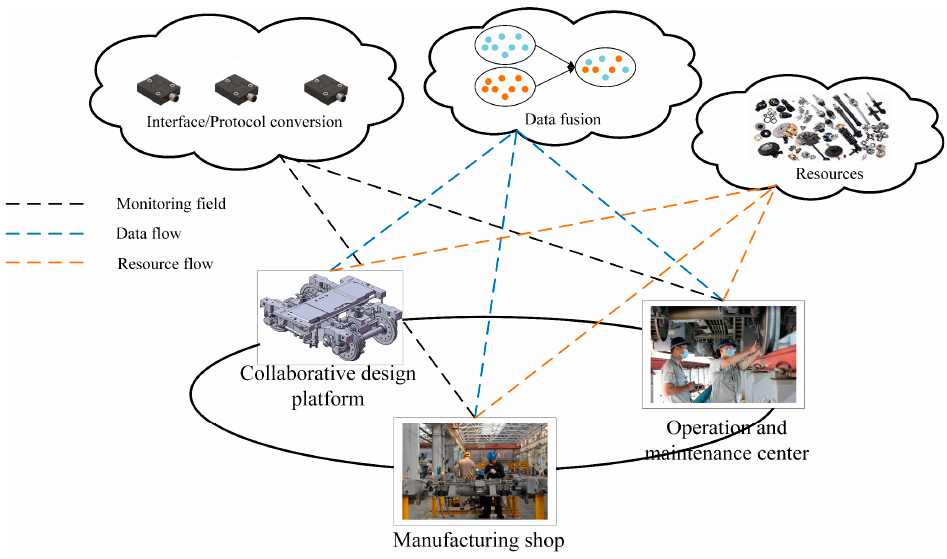
Figure 6. Design, Manufacture, and O&M ‐ integrated intelligent sensing system.